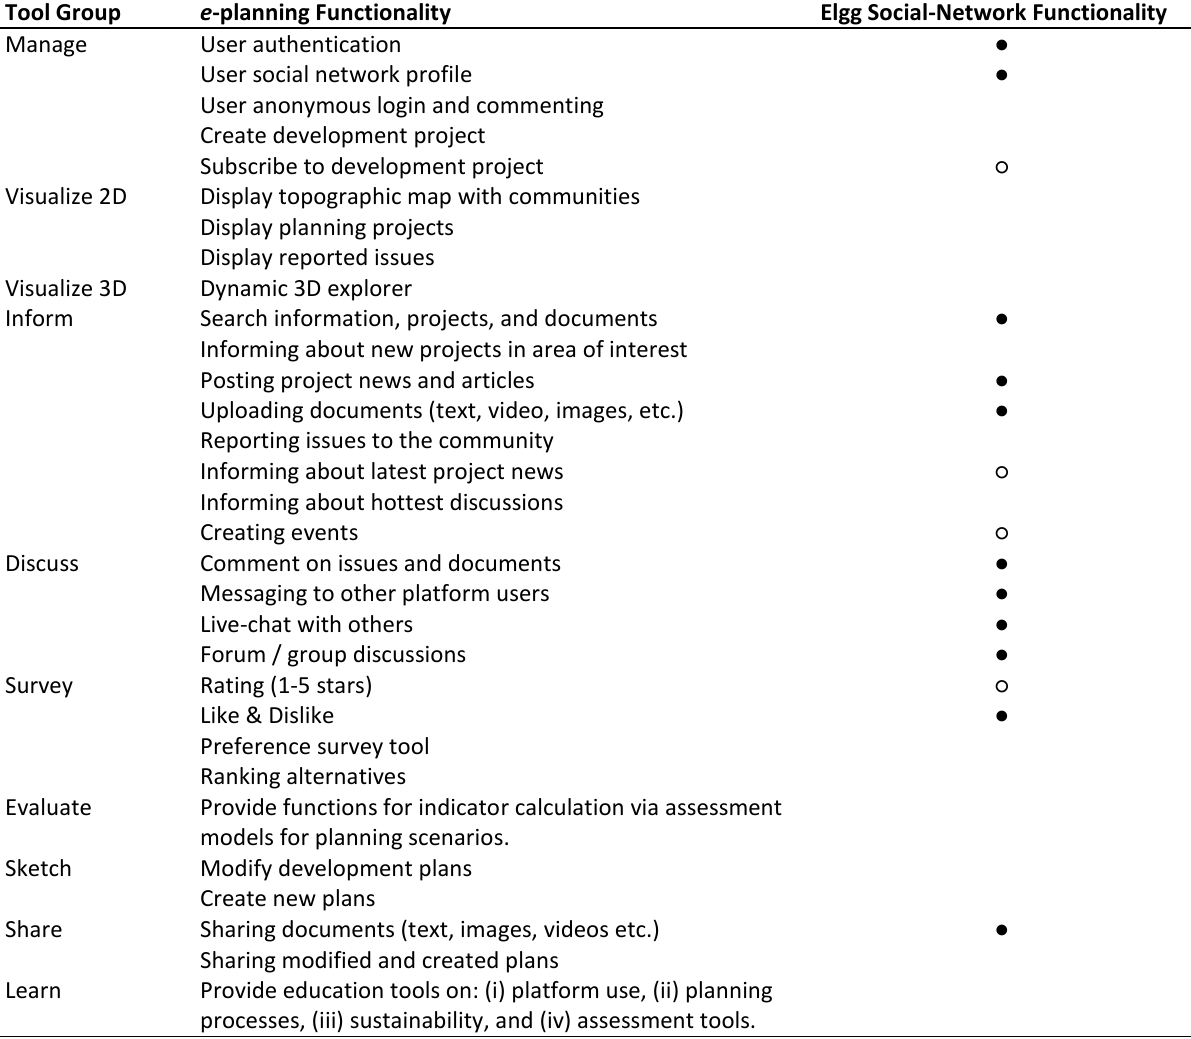
Table 1. Detailed functionality recommended for an e -planning platform. Tool